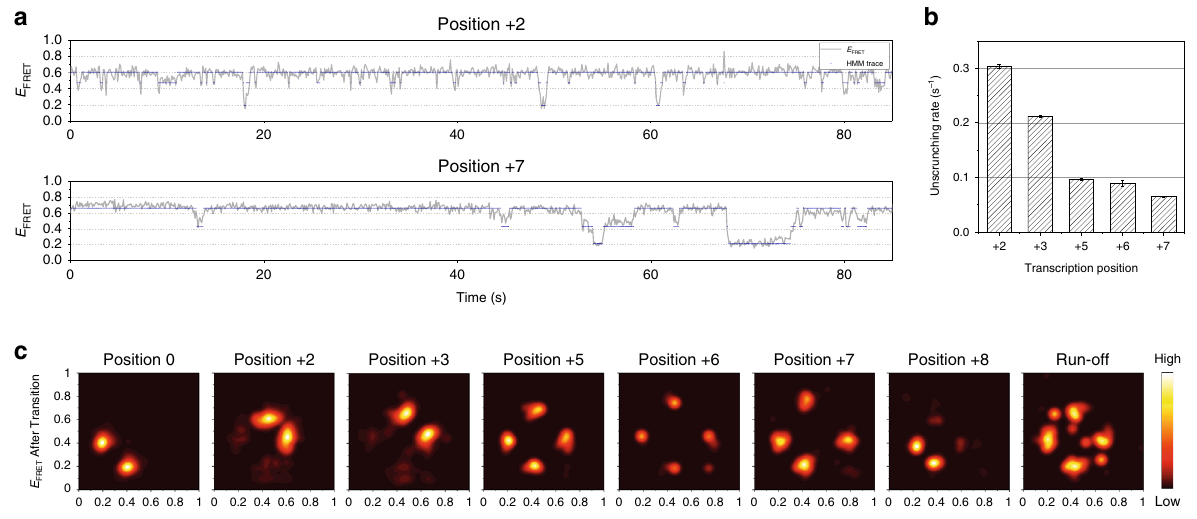
Fig. 4 Hidden Markov analysis throughout the initiation and elongation stages. a Representative smFRET traces (gray) at positions + 2 and + 7 shown alongside hidden state traces (navy) from hidden Markov modeling assuming three hidden states. b Unscrunching rates obtained from the hidden Markov analysis at each stalling position during initiation. Error bars represent the error in transition rate estimation in the hidden Markov analysis. c Transition density plots from hidden Markov analyses of traces at each stalling position. The 509, 184, 162, 45, 98, 51, 67, and 27 traces were used for positions 0, + 2, + 3, + 5, + 6, + 7, + 8, and run-off conditions,